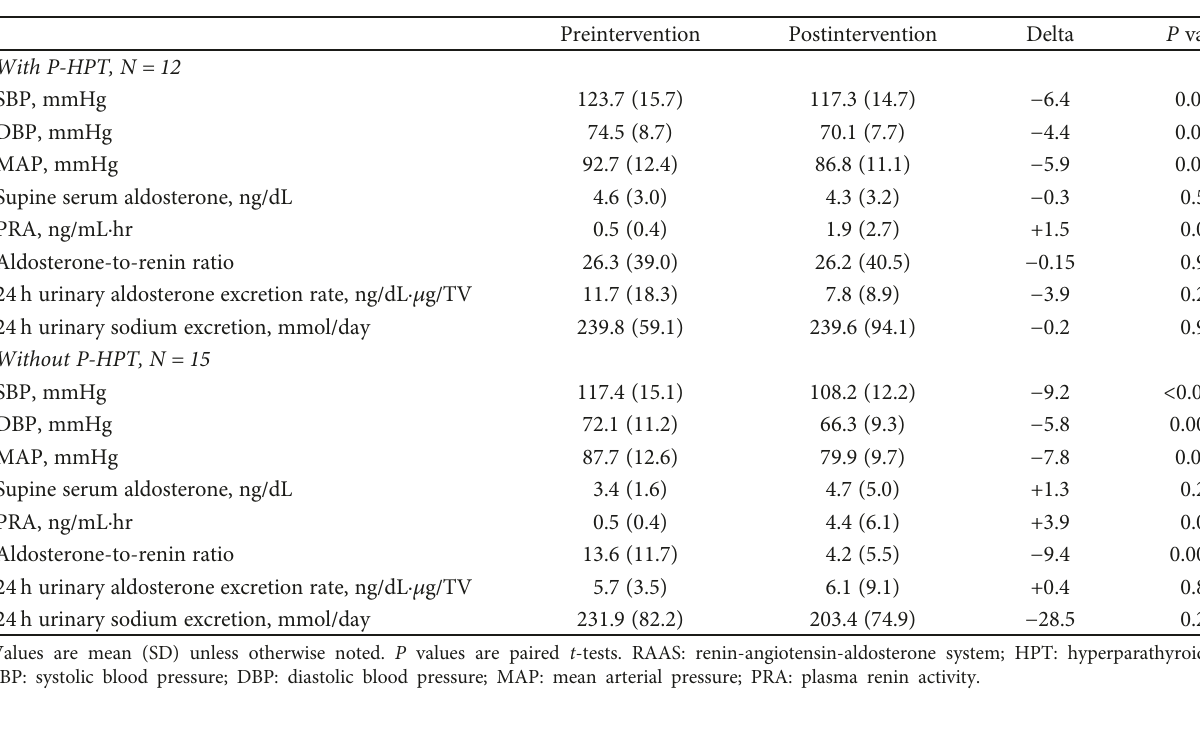
Table 2: Blood pressure and RAAS activity before and after lisinopril intervention.